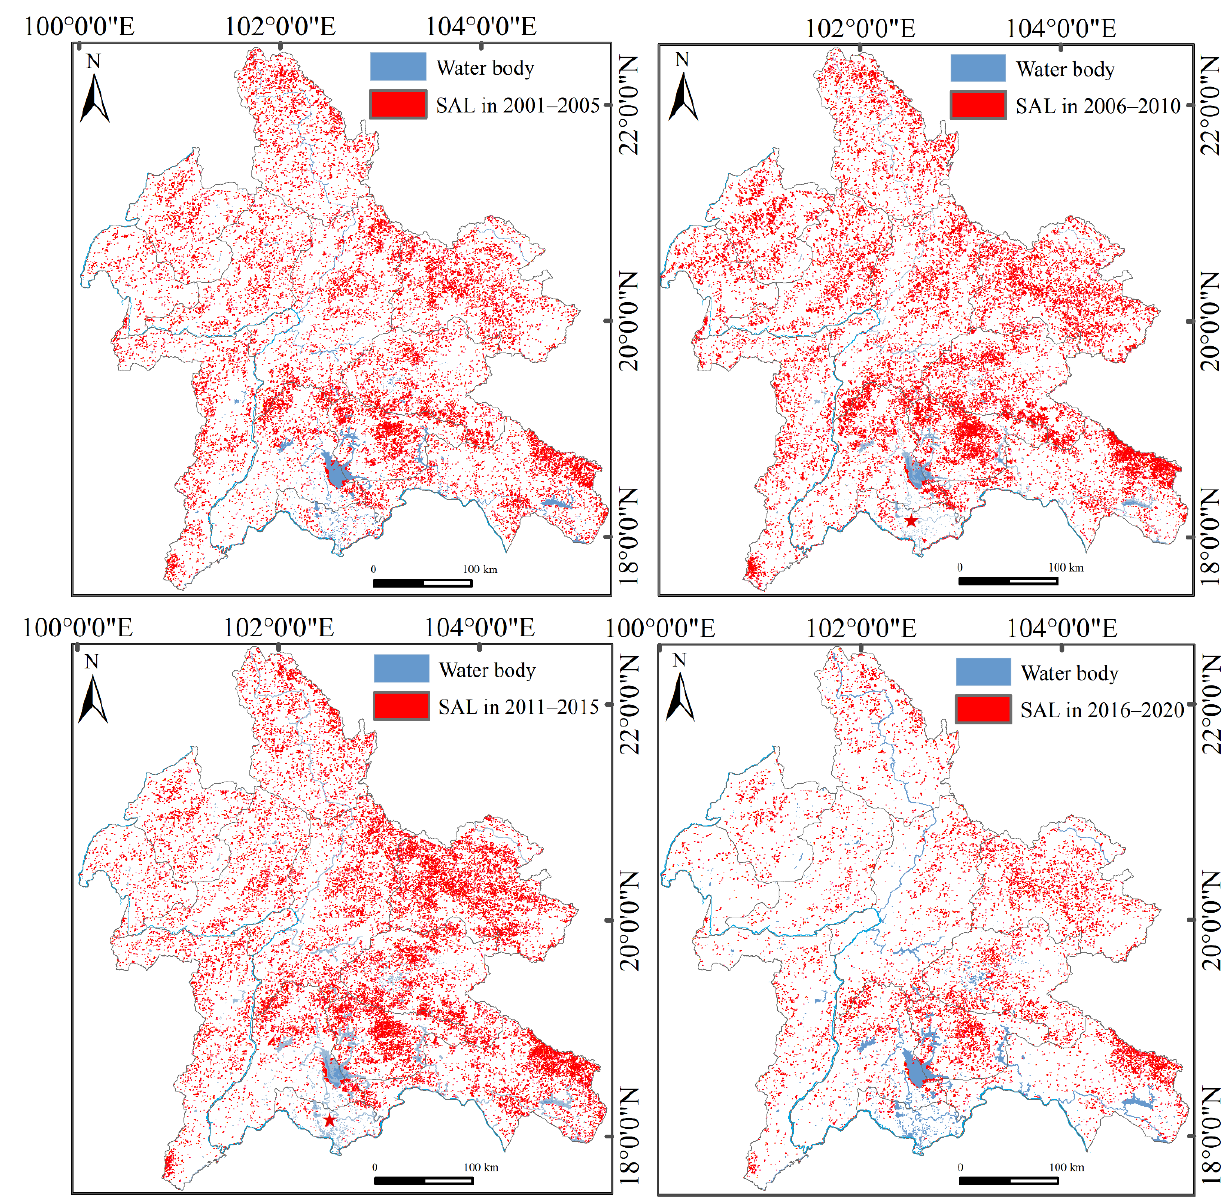
Figure 5. Maps of swidden agriculture landscape (SAL) in northern Laos at an interval of five years.